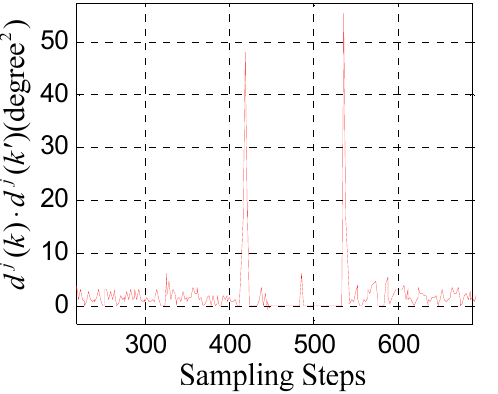
Figure 8. The product of the wavelet coefficients of the 1st and 2nd